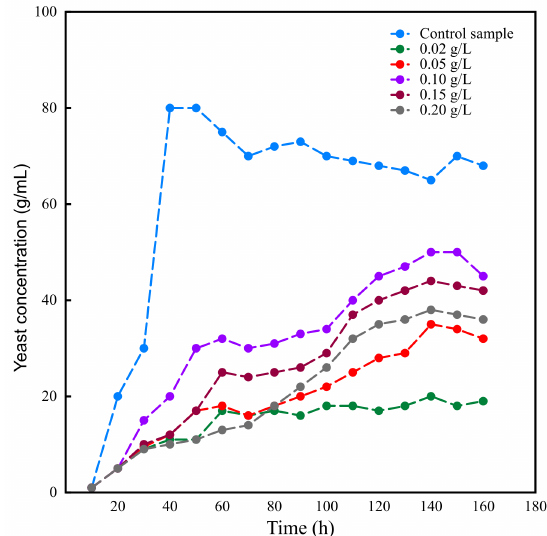
Figure 3. YSC concentration at different times using the control sample and extracted juice from pomace as a culture medium at different concentrations with a stirring speed of 100 rpm in a thermo-regulated bath and at a temperature of 30 ◦ C.